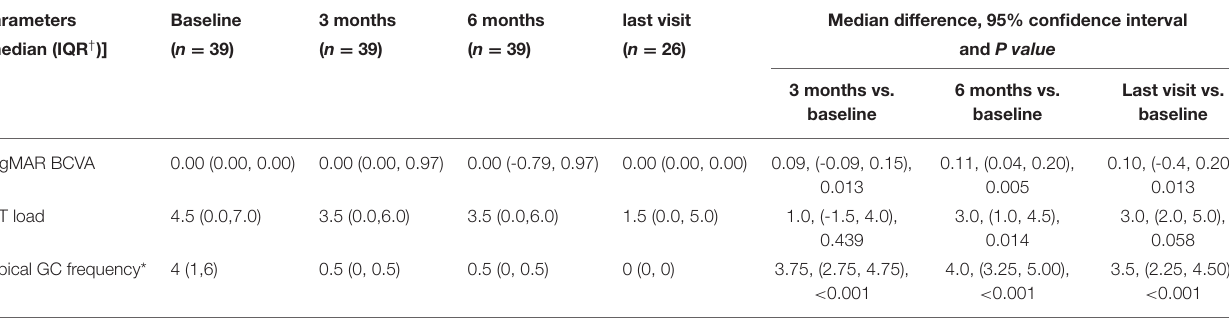
TABLE 4 | Other secondary outcomes at baseline, 3, 6 months, and the last visit if longer than 6 months follow-up available after adalimumab initiation.